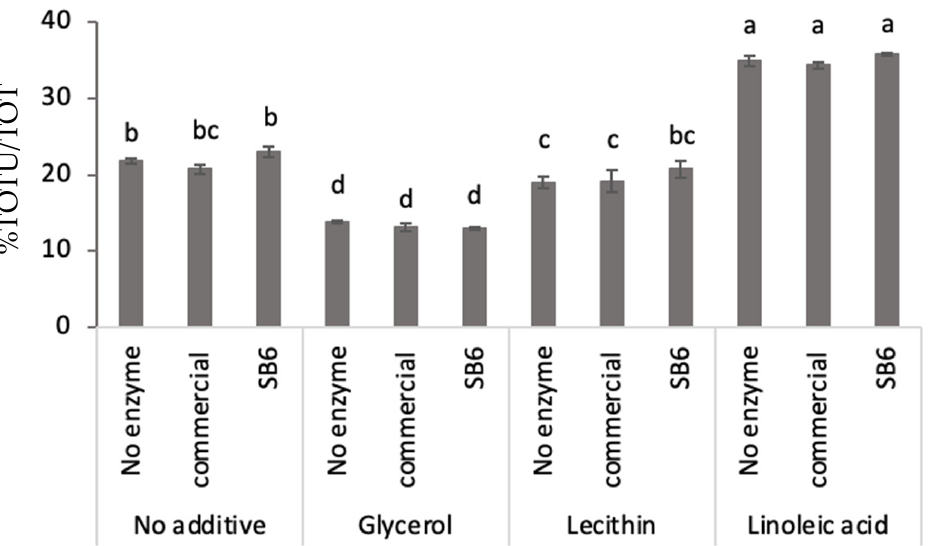
Figure 1. Protein polymerization measured as ratio of unextractable protein (TOTU) and total protein (extractable protein + unextractable protein) content (TOT), in solid lupin foams with and without different transglutaminases (commercial or SB6) and additives (glycerol, lecithin and linoleic acid). Error bars denote standard deviation; values with different letters (a–d) are significantly different; the means were compared at significant level of 5% using one-way ANOVA.